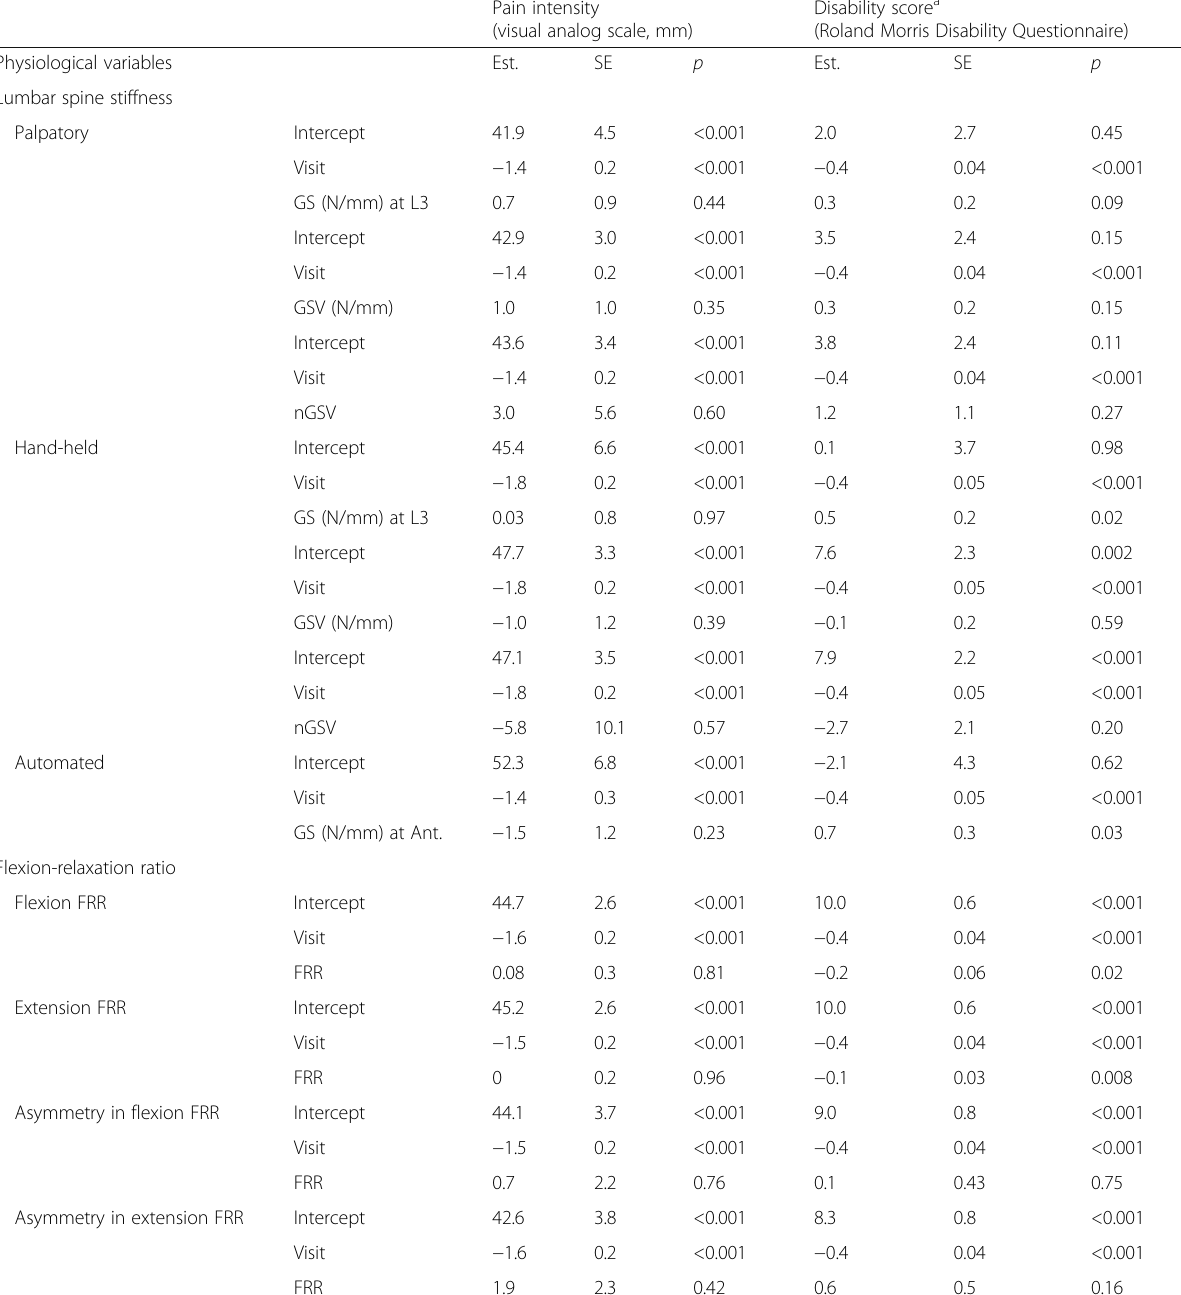
Table 5 Estimated regression coefficients from separate mixed-effects regression models of pain intensity and disability